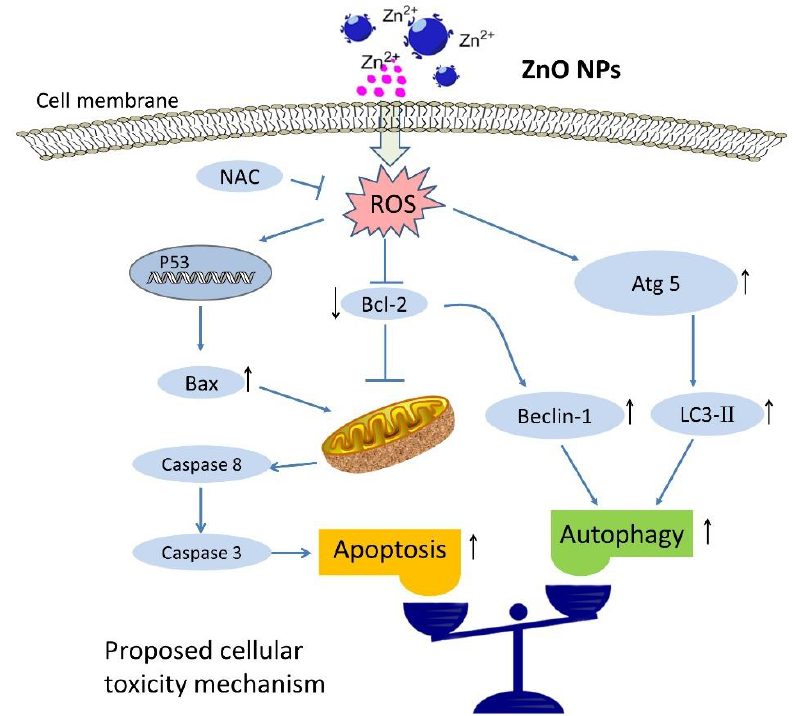
Figure 7. Schematic representation of the activation mechanism of apoptosis and cytoprotective autophagy in mouse Leydig cells after ZnO NP exposure. The up-regulation expression of protein is indicated by up arrow ( ↑ ), and down-regulation expression is indicated by down arrow ( ↓ ) in schematic illustration.